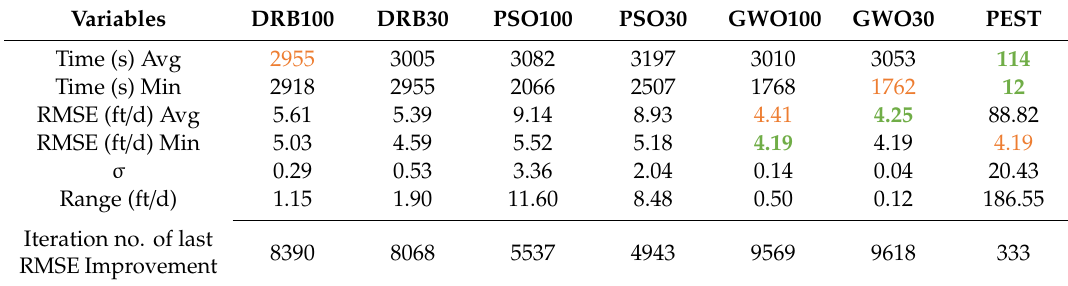
Table 2. Average and minimum (best) results from 15 runs from each pairing of optimizer and number of agents (best result in bold green, second best in orange).